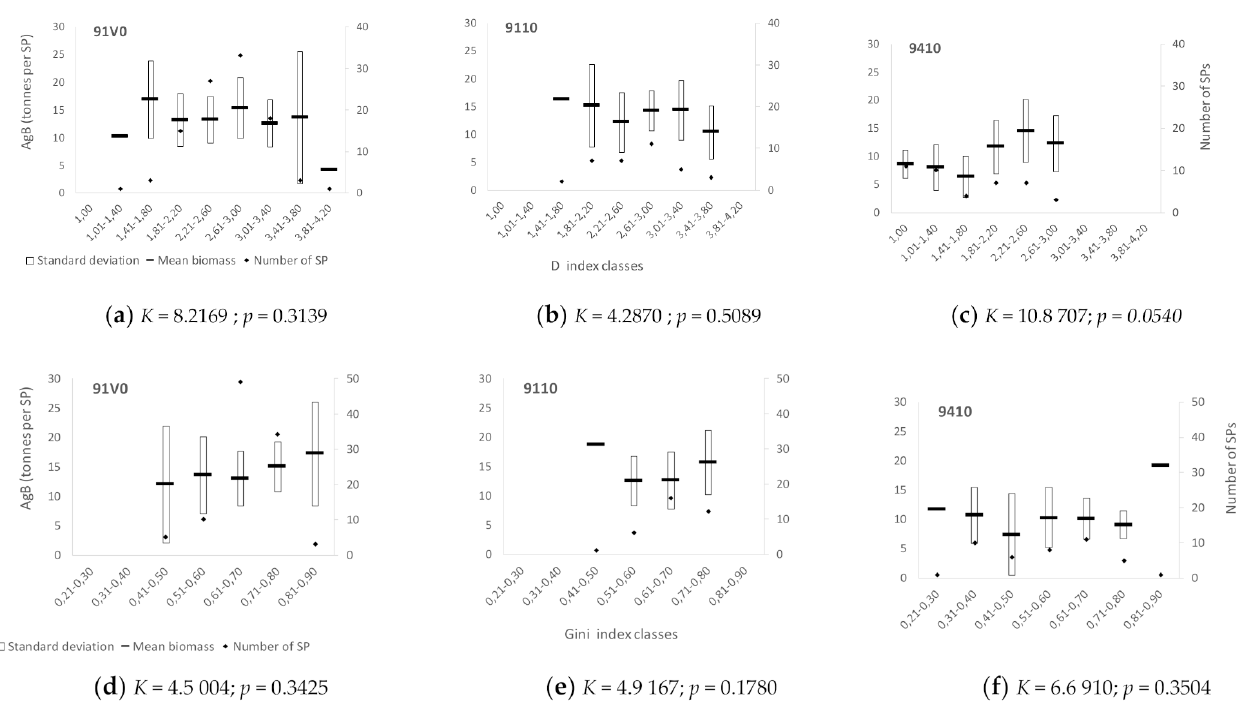
Figure 10. Distribution of the aboveground living trees biomass by tree species diversity ( a – c ) and tree size heterogeneity class ( d – f ), in SPs assigned to different Natura 2000 habitat types. K represents the Kruskal–Wallis constant, while p indicates the significance